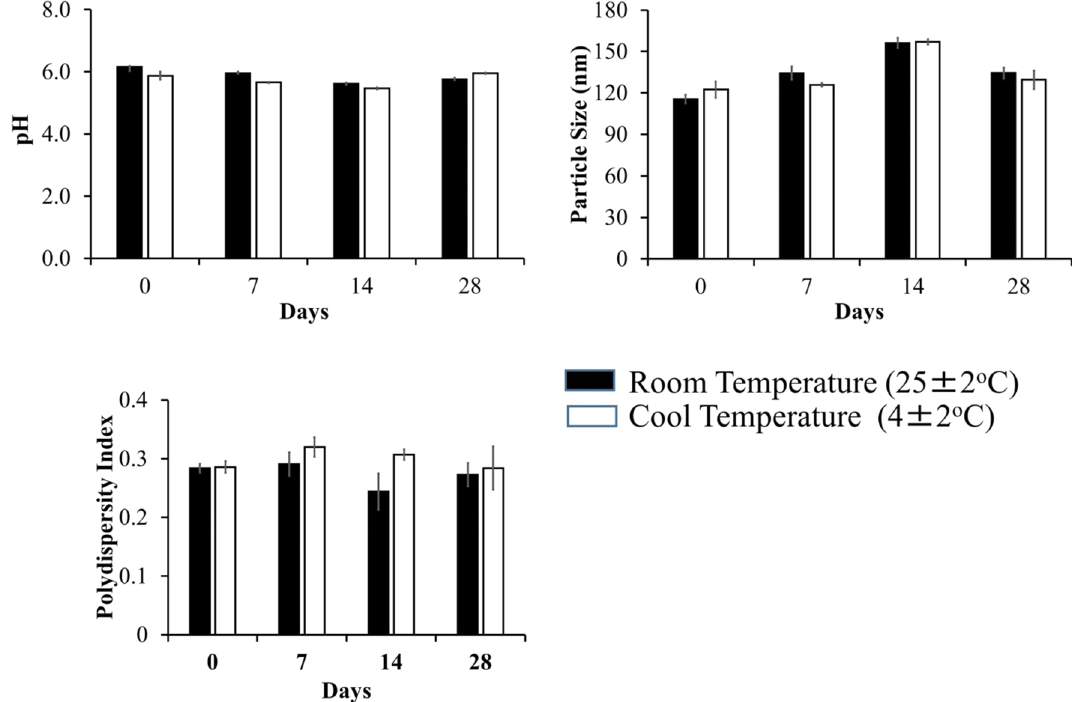
Figure 5. Evaluation of particle size, polydispersity index, and pH stability of protransfersomal CoQ10 loaded in emulgel (Protransf-CoQ10 Emulgel) during 28 days stored at room (25 ± 2 °C) and cool (4 ± 2 °C)